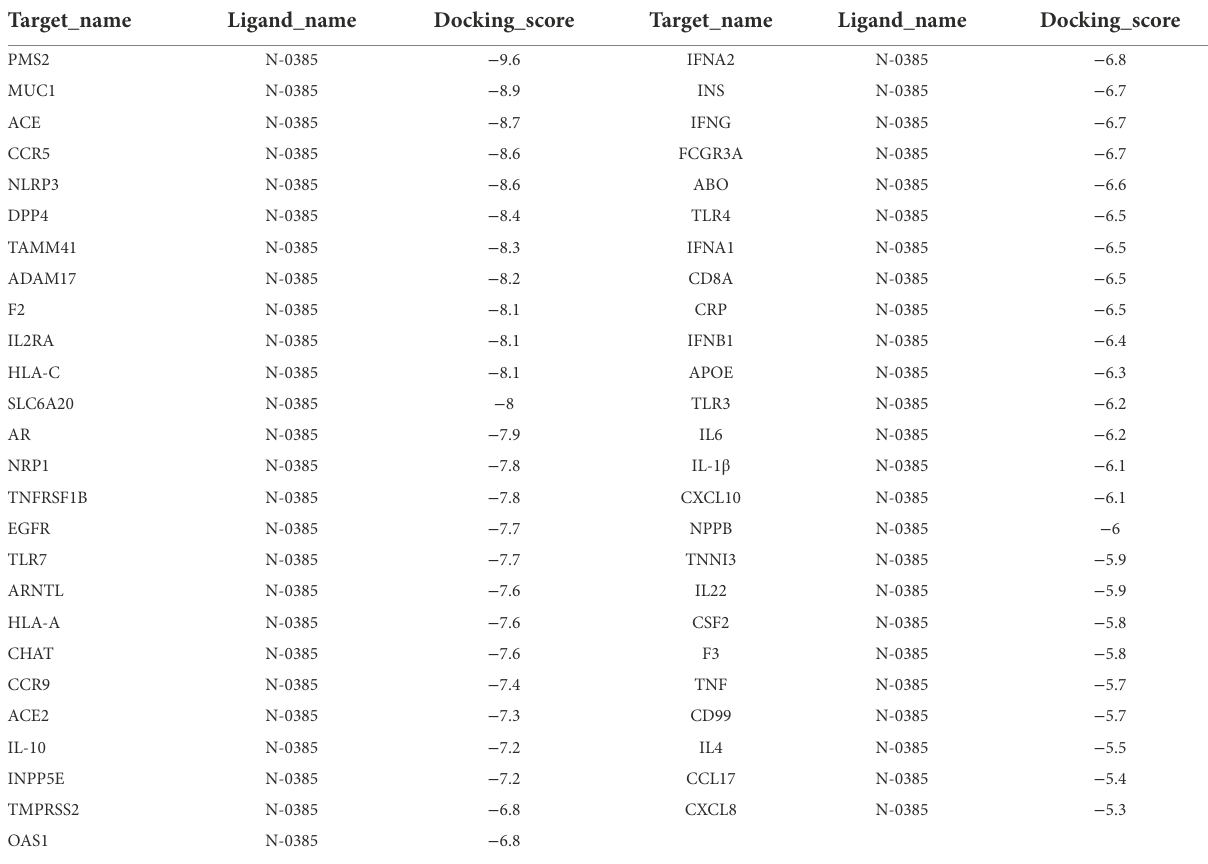
TABLE 1 Results of molecular docking